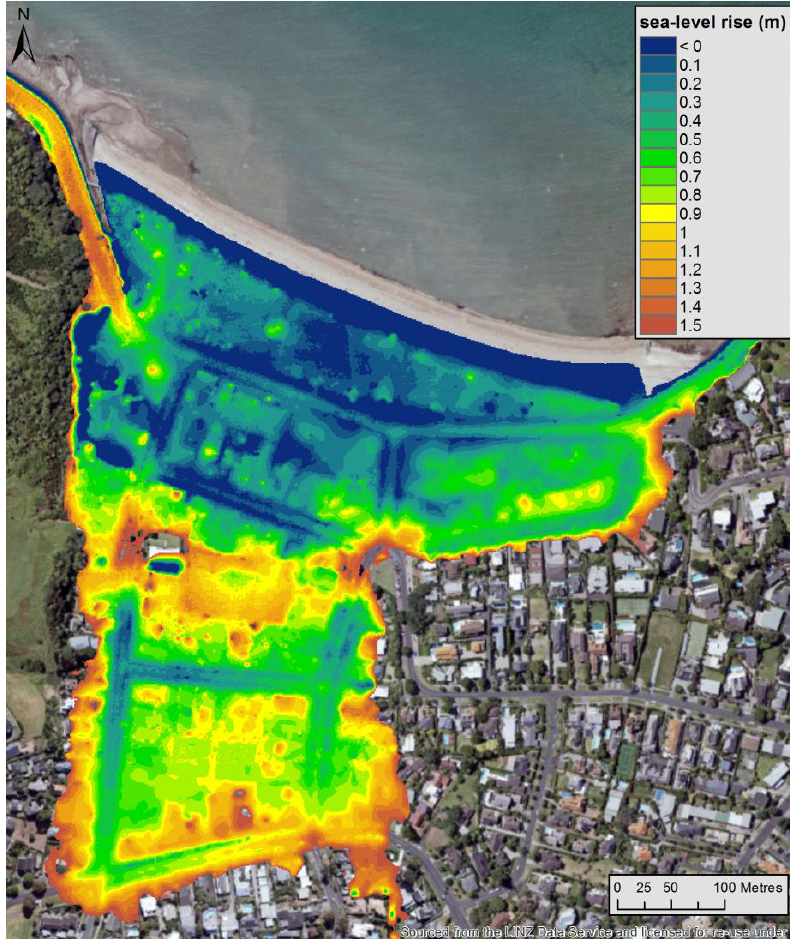
Figure 5. The effect of 0.1 m SLR increments on coastal-storm flood exposure at Mission Bay (Auckland). SLR increments have been added onto the 1% AEP storm-tide elevation, which was calculated for the present-day mean sea level.